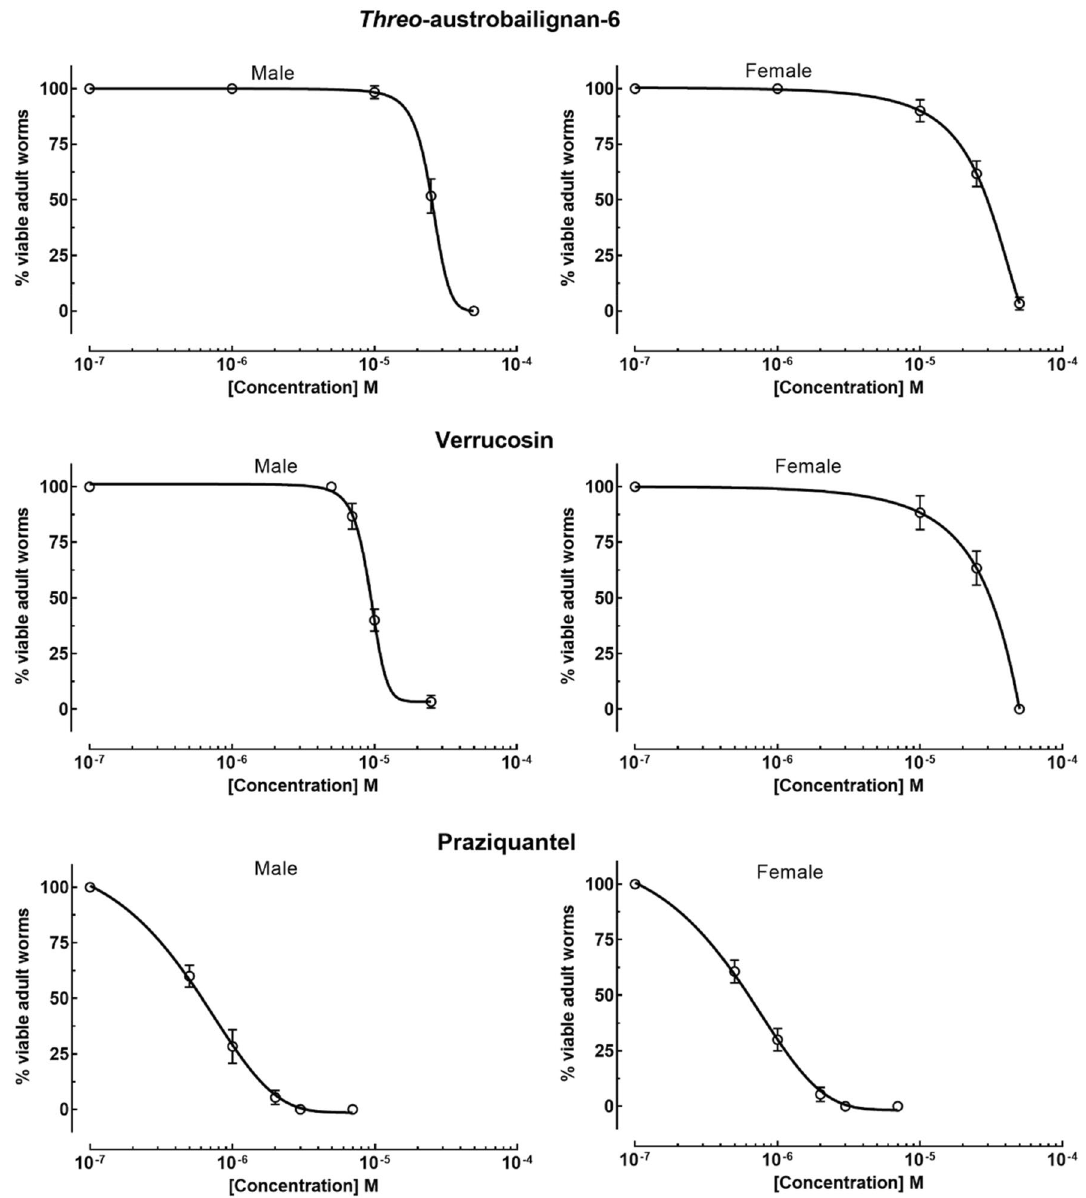
Figure 2. Concentration–response curves for threo-austrobailignan-6, verrucosin, and praziquantel. Viability of ex vivo adult S. mansoni worms (male and female) was recorded within 72 h. Data are presented as the mean ± SD from a minimum of three experiments ( n = 3). EC 50 values are shown in Table 1.